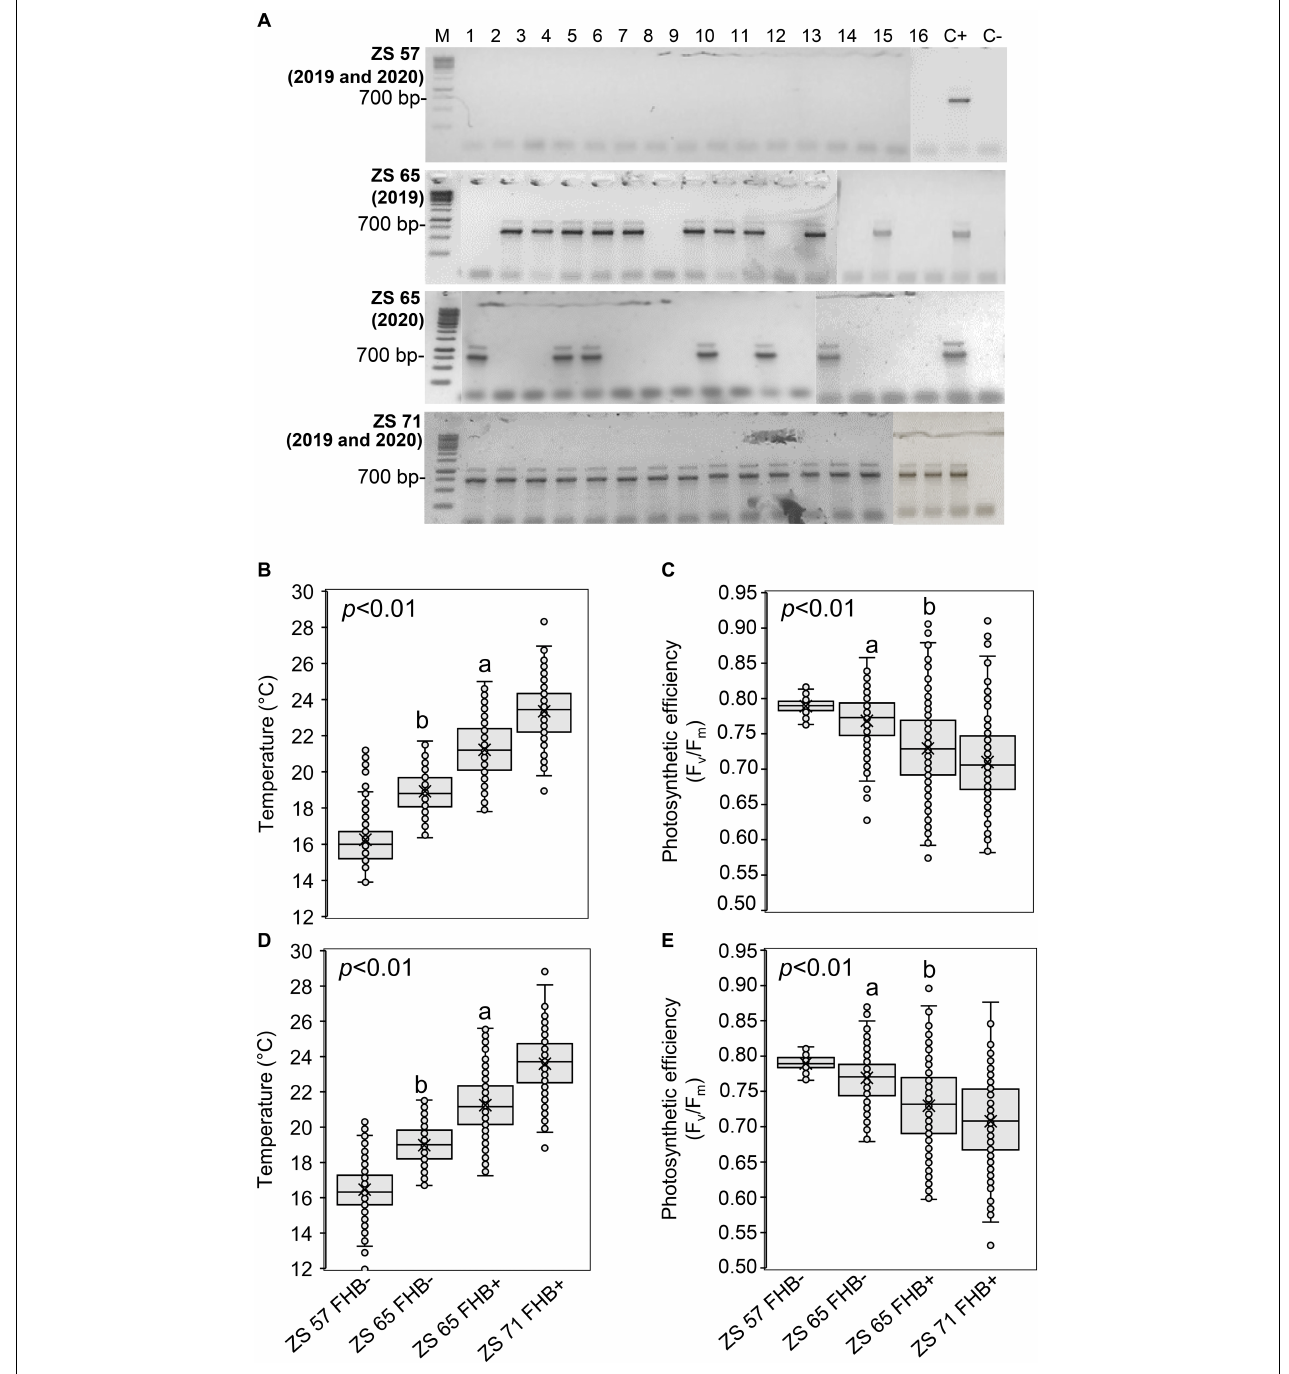
FIGURE 3 | Molecular identification of Fusarium head blight (FHB) and ground-based temperature and photosynthetic efficiency measurements recorded in concurrence with unmanned aerial vehicle (UAV) campaigns conducted at Zadoks stage (ZS) 57, 65, and 71 of Triticum turgidum (cv. Marco Aurelio) in 2019 and 2020. (A) Molecular identification of Fusarium spp. using 1.5% agarose gel of the translational elongation factor 1- α ( TEF ) sequence (700 bp) in spikes of isolates obtained from the 16 sampling areas, sampled in 2019 and 2020 at ZS 57, 65, and 71. At ZS 57, none of the 16 sampling areas resulted FHB positive (FHB+) during both 2019 and 2020 UAV campaigns; at ZS 65, 10 and 6 sampling areas were FHB+ in 2019 and 2020, respectively; at ZS 71, all sampling areas were FHB+ during both 2019 and 2020 UAV campaigns. M represents a 100 bp DNA Ladder (Jena Bioscience); C- represents the negative control and C+ represents the presence of F. graminearum wild type (WT) 3824. The figure is obtained from four gels and the original pictures of the gels are available upon request. (B,D) Box-plot of the spikes’ temperature ( ◦ C) and (C,E) photosynthetic efficiency (F v /F m ). The data represent averages and standard errors for 256 spikes (16 spikes for each sampling area) from 2019 (B,C) and 2020 (D,E) . Different letters refer to the statistical analysis performed using one-way analysis of variance (ANOVA) with the Tukey’s honest significant difference (HSD) post hoc test at 0.95 or 0.99 confidence level and p < 0.05 or p < 0.01.